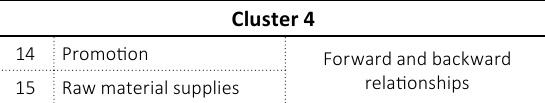
Table 3. Codes comprising Cluster 2